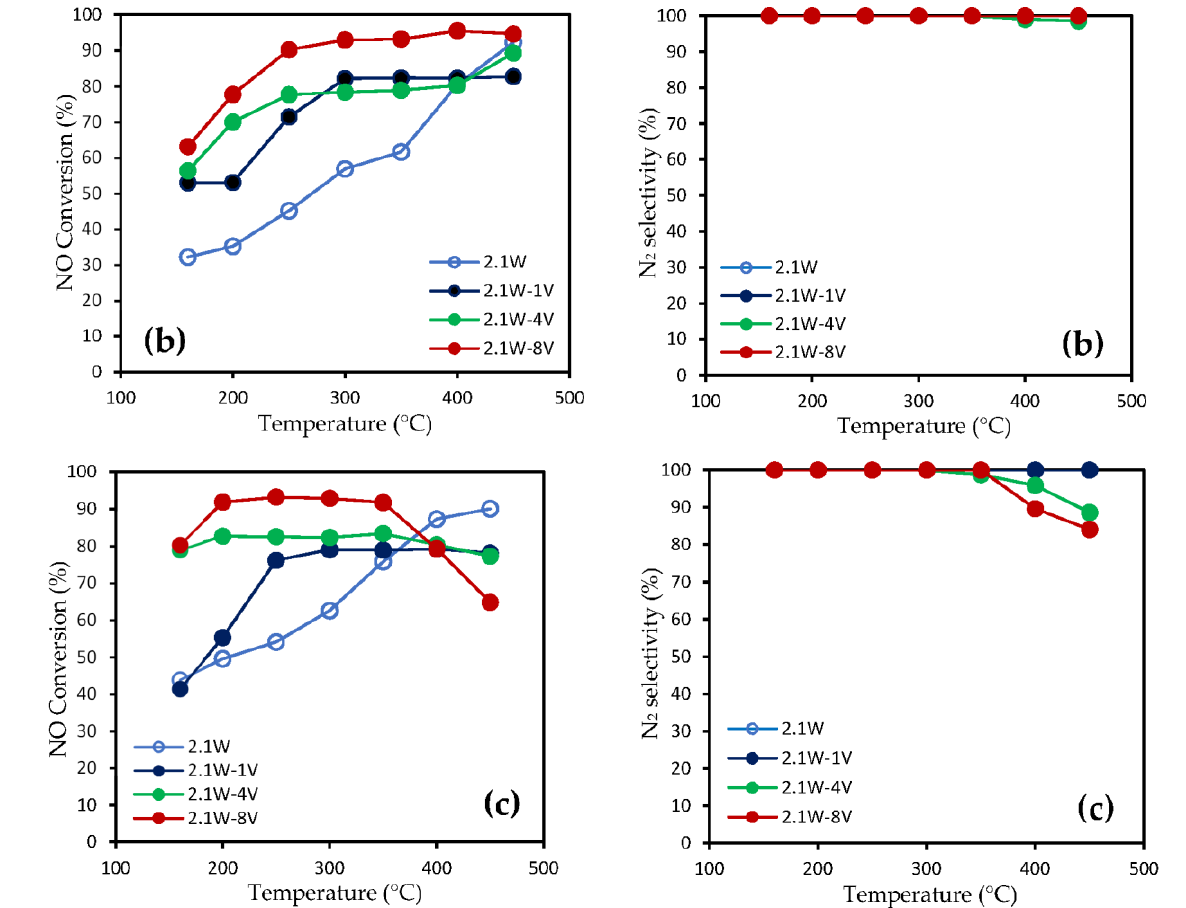
Figure 2. Conversion and N 2 selectivity profiles vs. temperature recorded on 2.1W- x V during am-